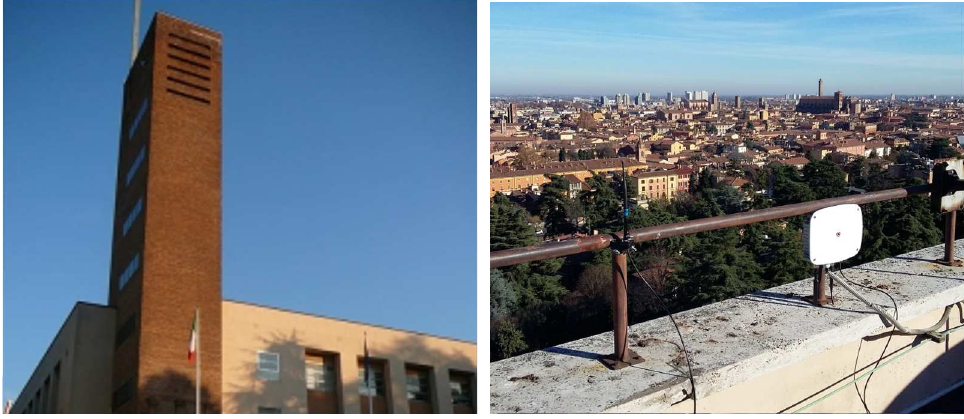
Figure 5. LoRa gateway